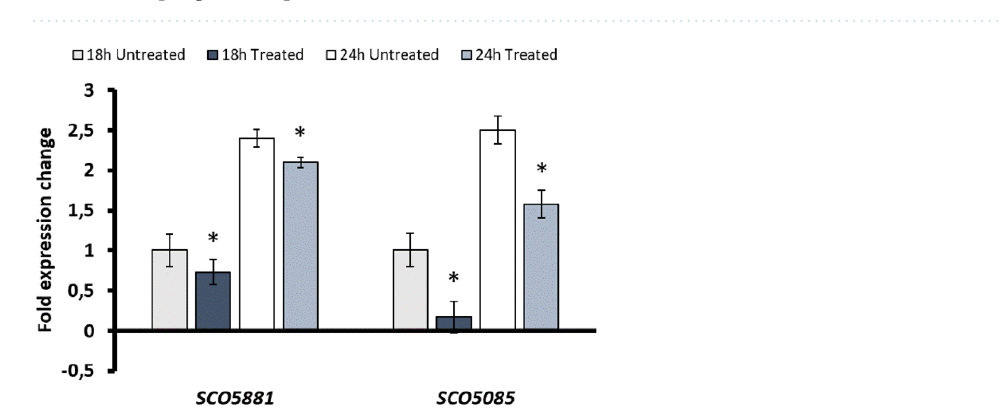
Figure 6. RT-qPCR analysis of SCO5820, SCO2960, SCO2571, SCO2072, SCO2964, SCO3911, SCO3732, SCO2716, SCO6164, and SCO6685 genes after 18 h ( a ) and 24 h ( b ) of growth of untreated and 5-aza-dC treated cultures. mRNA levels are expressed as relative values to 16S rRNA transcripts, with the ratio values for the 18 h sample arbitrarily set to 1. The standard deviations (indicated by error bars) were calculated from three independent determinations of mRNA abundance. The asterisks indicate significant differences compared to the untreated sample ( p -value equal to or less than 0.05).